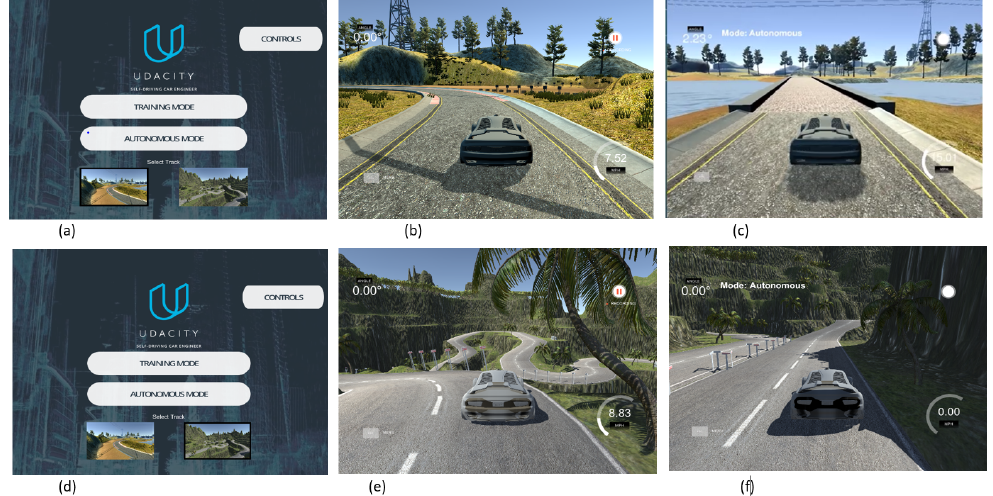
Figure 5. The Lack track has three scenarios: ( a ) Lack track environment; ( b ) data recording screen; ( c ) autonomous mode. The Mountain track has three scenarios: ( d ) Mountain track environment; ( e ) data recording screen; ( f ) autonomous mode.